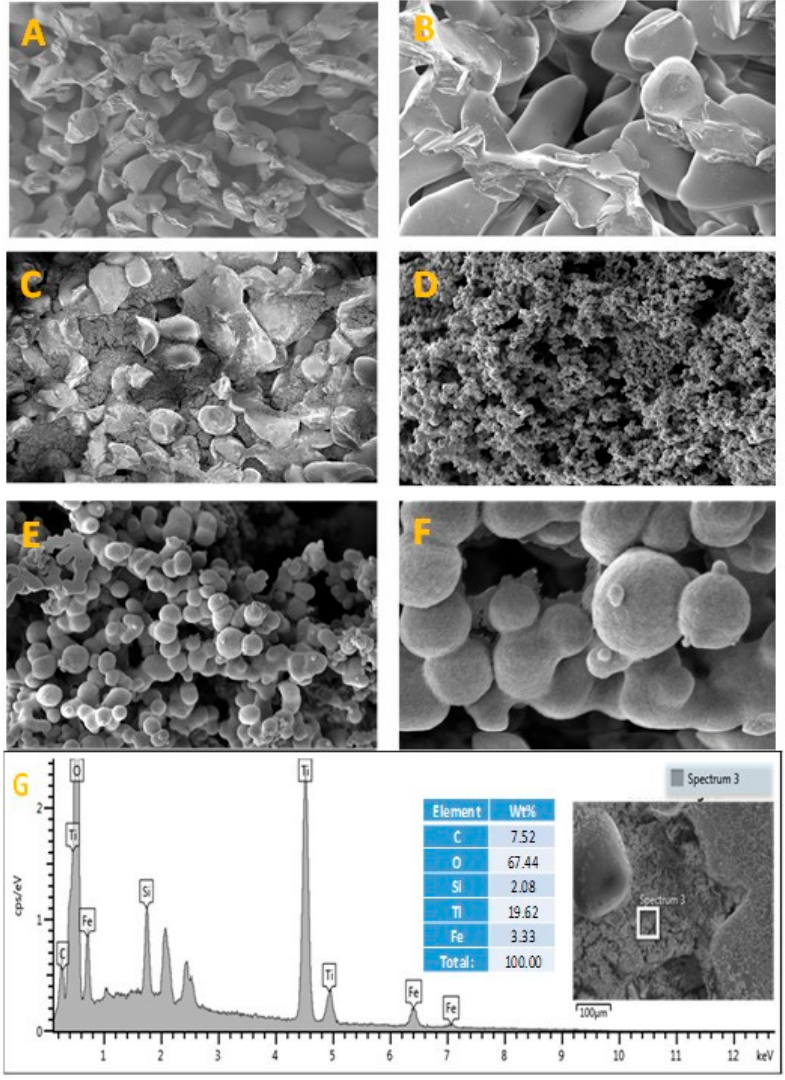
Figure 2. FESEM images of the ( A , B ) annealed bare clay filter and ( C – F ) Fe-TiO 2 -coated clay filter at different magnifications, and ( G ) EDS spectra along with weight % of elements.